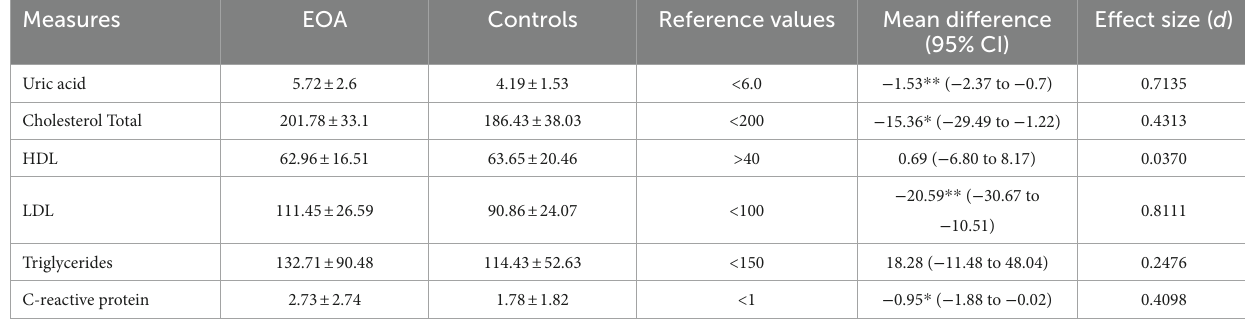
TABLE 2 Differences between groups.